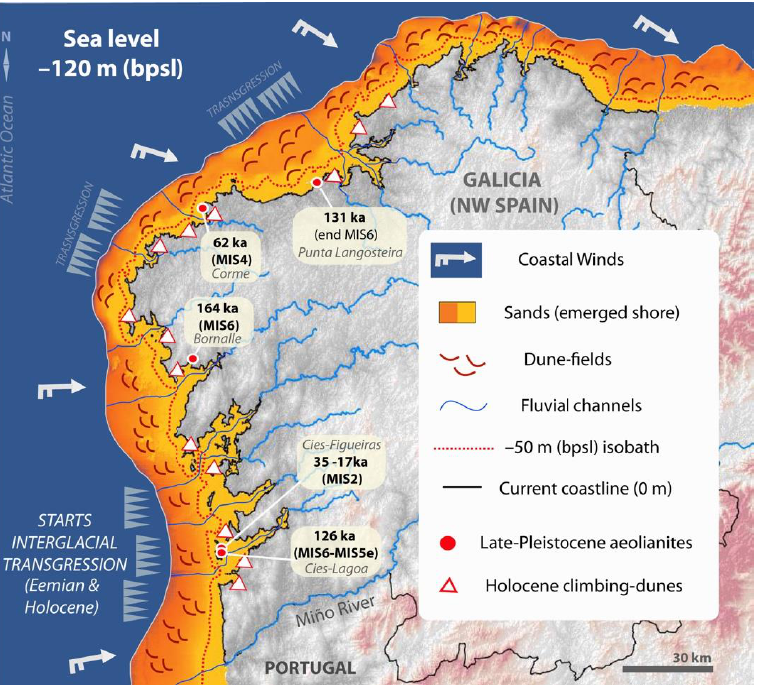
Figure 5. Climbing dunes and the evolution of the Atlantic coast of Galicia (NW Spain) during Late Pleistocene regressive cold events. A model map of the coastline at 120 m and 50 m (bpsl) (blue area and red dotted line, respectively) during MIS6, MIS4 and MIS2 [39,40] and the emerged strip of the continental platform covered by sand [16] (orange and yellow areas), using the bathymetric data from EDMOnet [19]. Sand was transported by coastal winds as proposed by Costas et al. [18]. The red dots show the location of the IRSL-dated climbing dunes in this paper and the climbing dune from Figueiras, in the Cíes Islands, [8] dated by OSL as from 35 ka to 17 ka (MIS2) [39]. All of these fossil climbing dunes were located in the area of the current coastline, from a lower sea level. Dune fields (hypothetically represented) were mobilised towards the continent during the Eemian and Holocene transgressions, only stopping when the sea reached its present level and flooded the emerged continental shelf (as evidenced by the relic dunes preserved on the current coast of Galicia: white triangles).